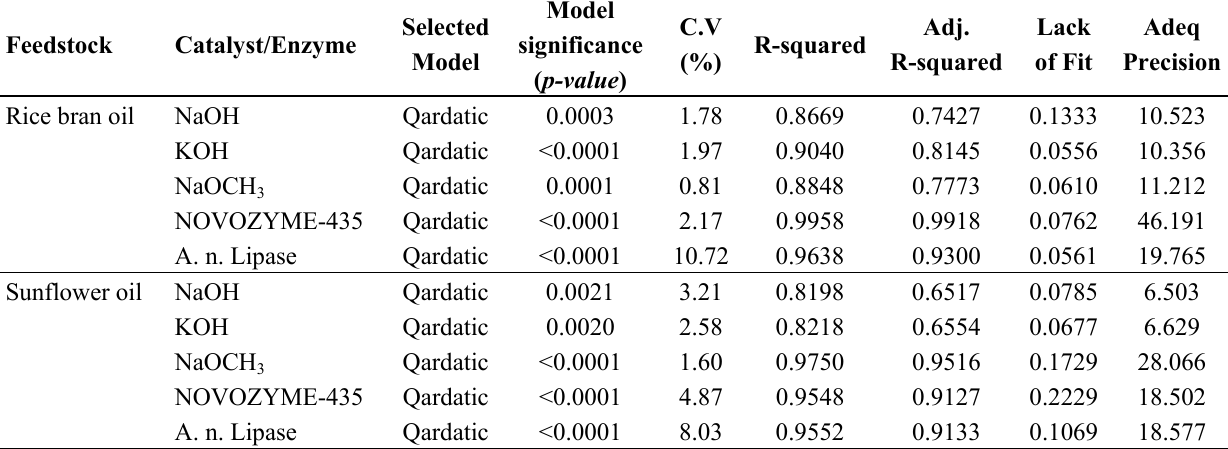
Table 2. Summery statistics of selected models used for optimization of biodiesel production using chemical and enzymatic